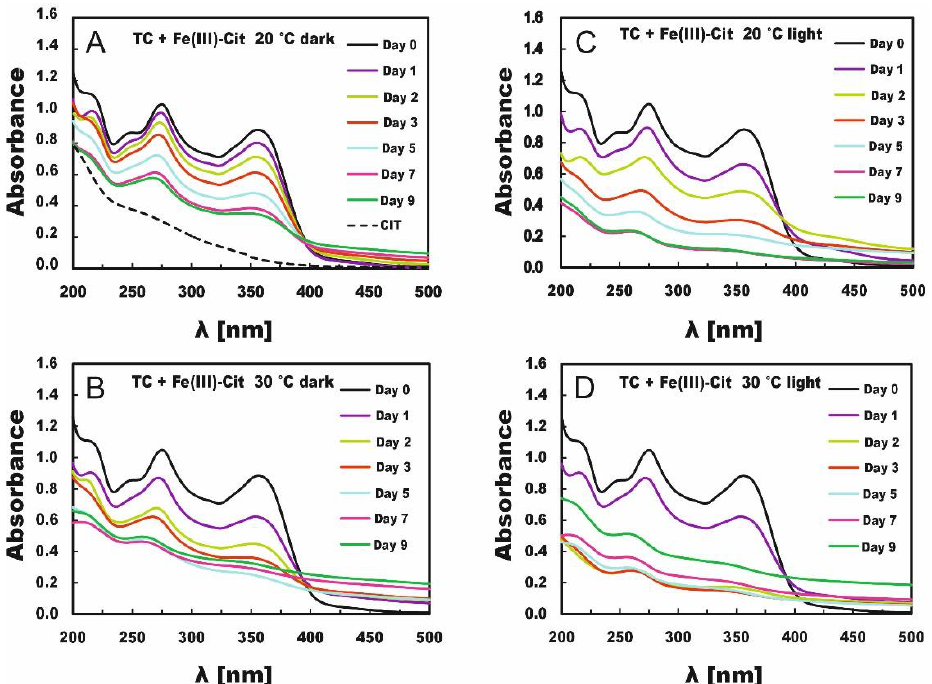
Figure 2. Changes in TC absorption spectra under the influence of Fe(III)-Cit in solutions stored in the dark ( A , B ) or in light ( C , D ) at 20 °C ( A , C ) and 30 °C ( B , D ).